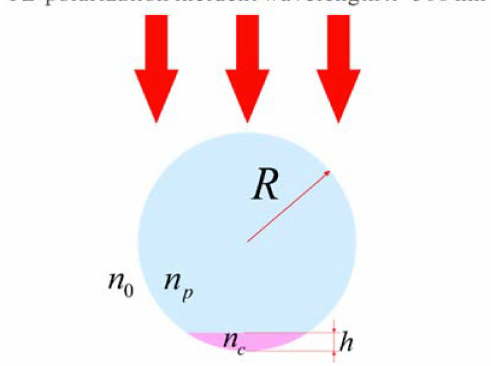
Figure 1. A mesoscale Janus particle illuminated under a TE-polarization plane wave.